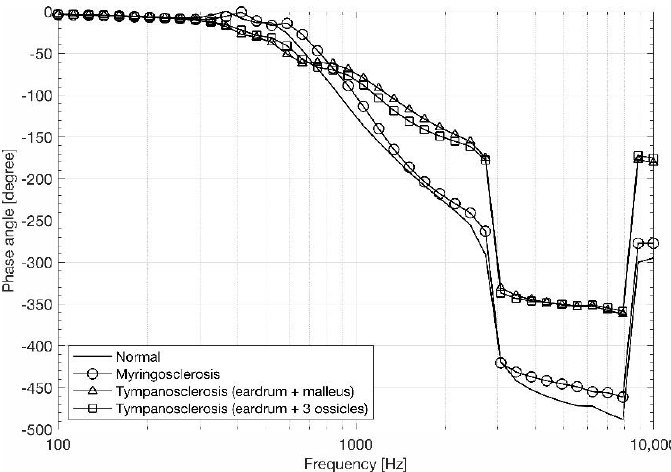
Figure 7. Phase angles for the umbo, comparing different situations.